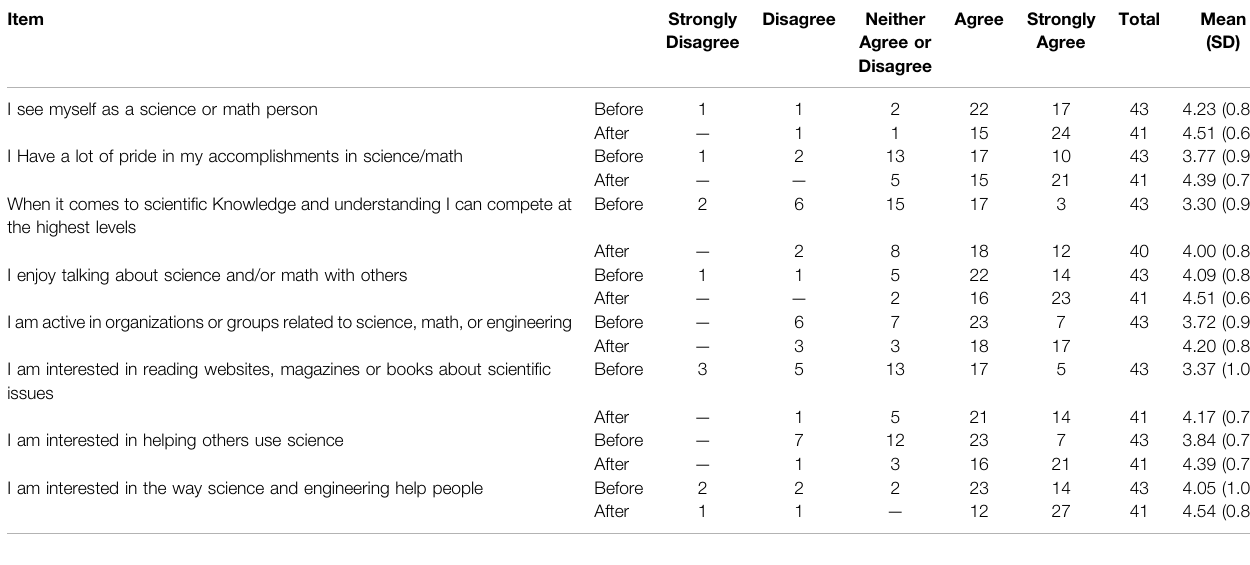
TABLE 10 | Items related to STEM identity. Item Strongly